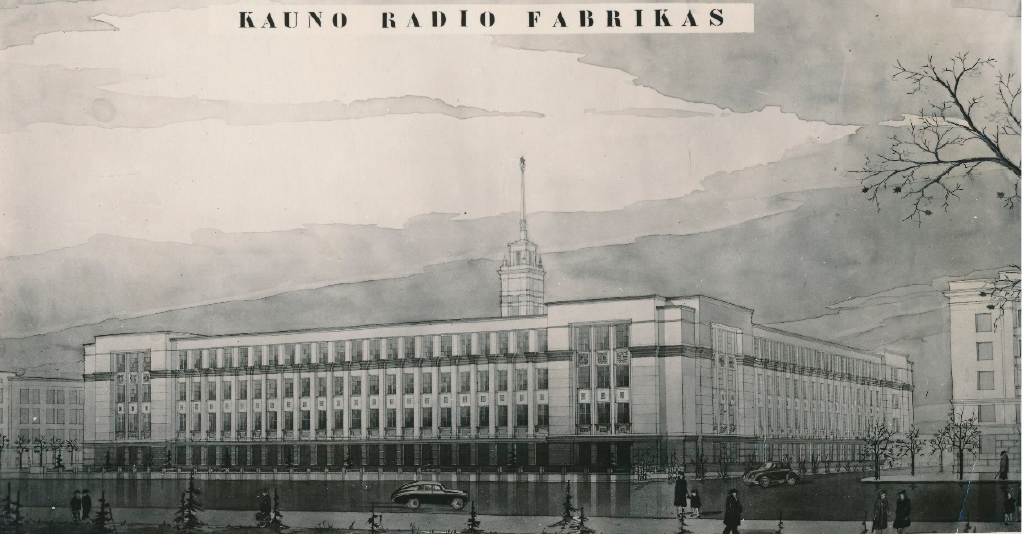
Figure 12. The project plan of the Kaunas Radio Factory, 1950s (source: Kaunas City Museum). On 20 March 1952, by decision of the Executive Committee of the Kaunas City Coun- cil of People’s Deputies, the land on which the buildings of the Kaunas St Andrew’s